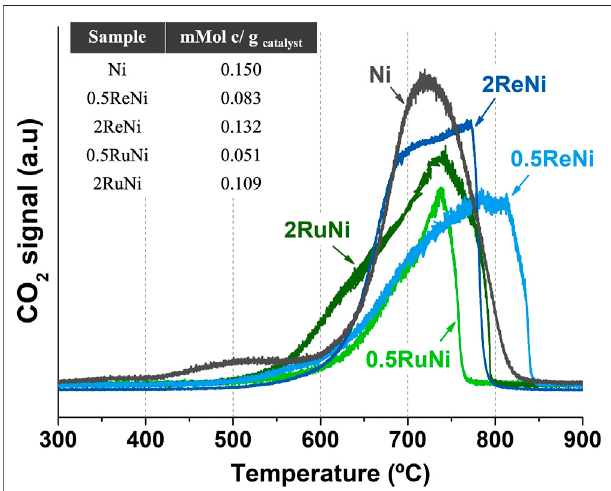
FIGURE 7 | TPO analysis of the postreacted